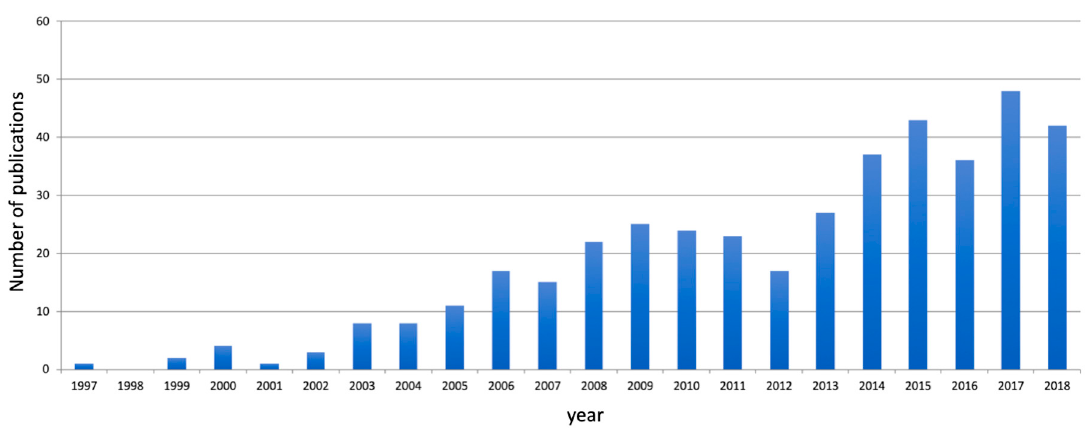
Figure 3. Papers published until December 2018 on GBRI.